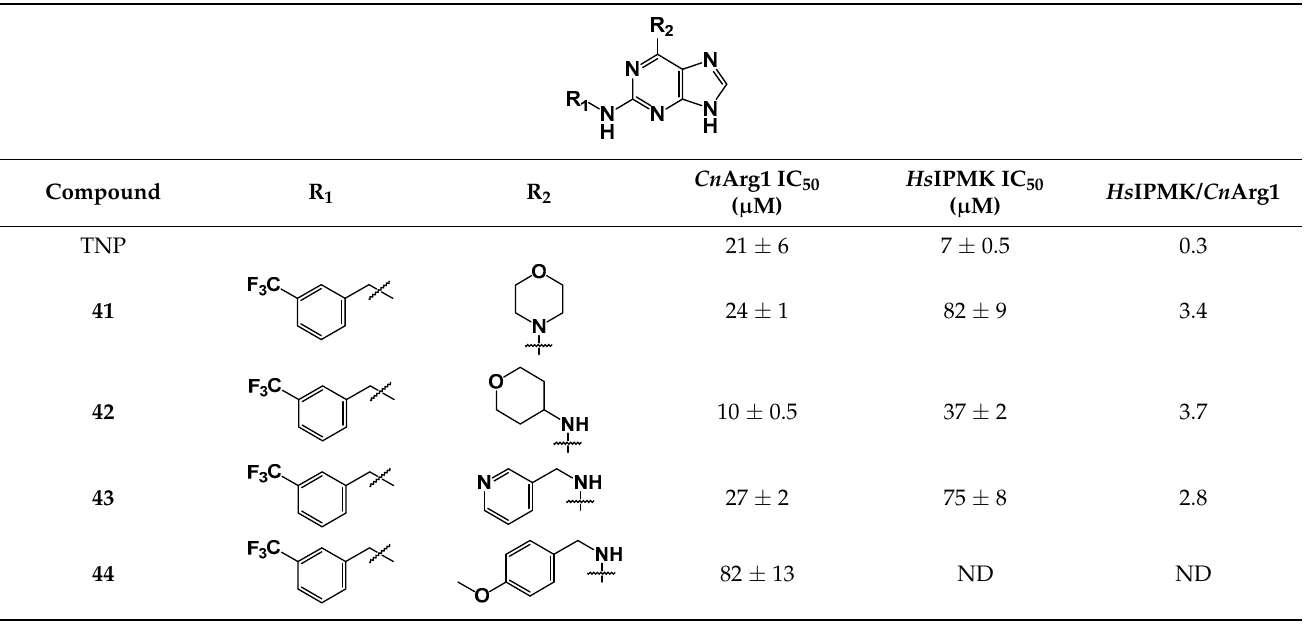
Table 6. Exploration at the N 9 position on the TNP purine core abolished inhibition against Cn Arg1. ND = not determined.